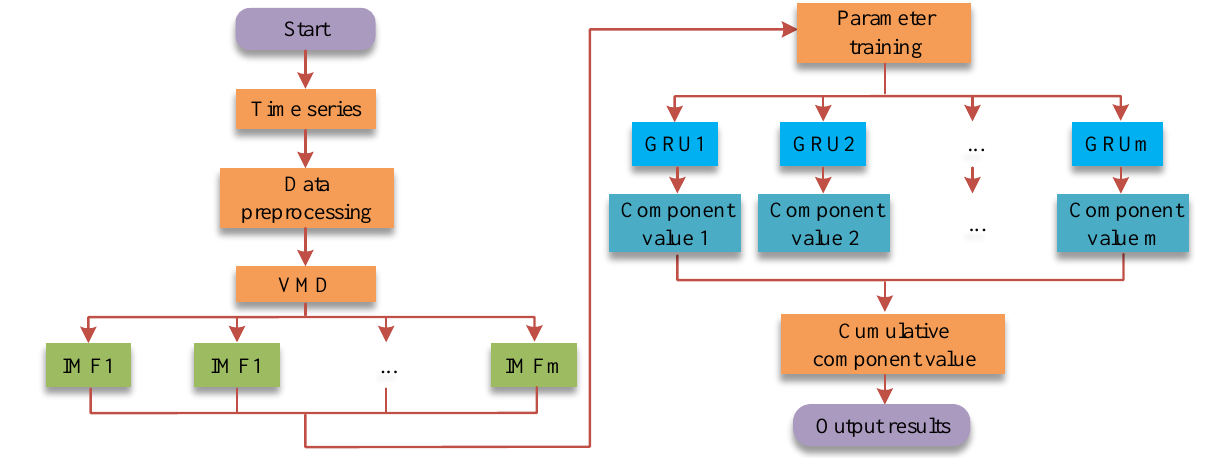
Figure 3. Short-term prediction process of VMD-GRU algorithm.